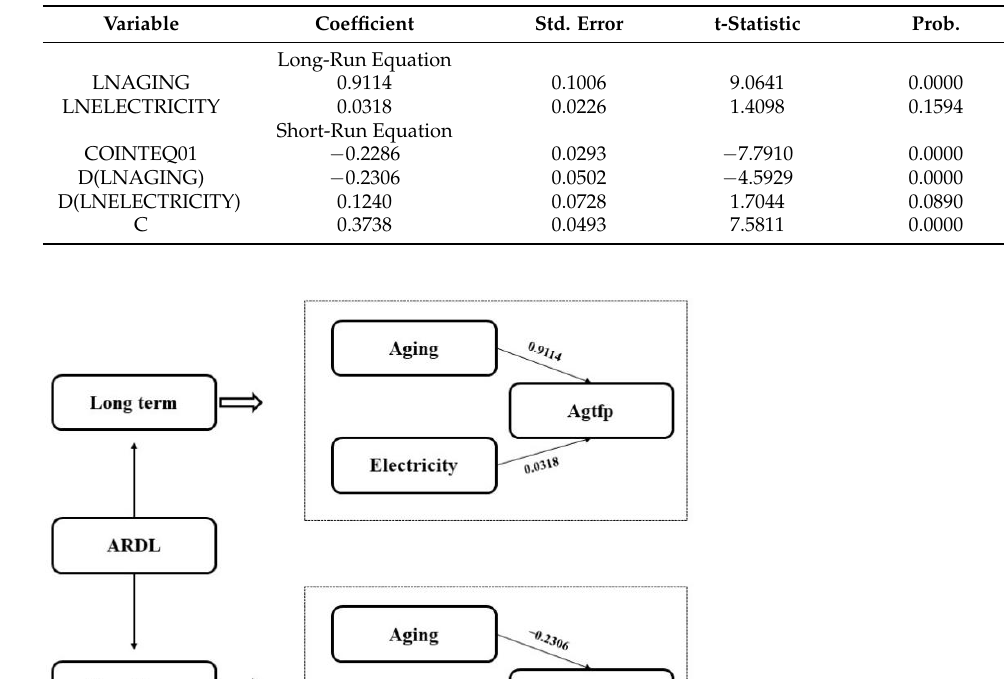
Table 4. ARDL analysis results.